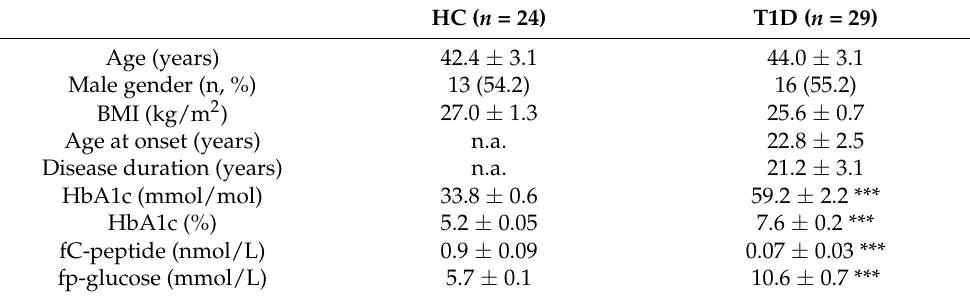
Table 1. Characteristics of research subjects.